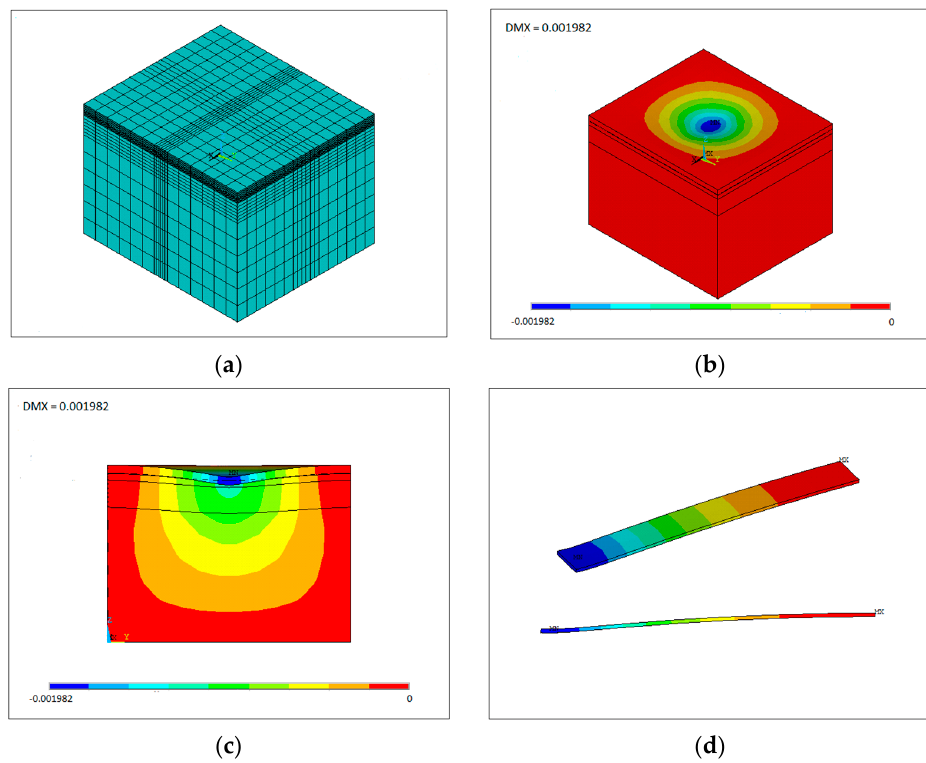
Figure 2. The four figures are as follows; ( a ) The 3-D finite element model; ( b ) The rutting deformation developed from the load; ( c ) Cross-section view of the rutting deformation; ( d ) Half surface strip of the deformed model.